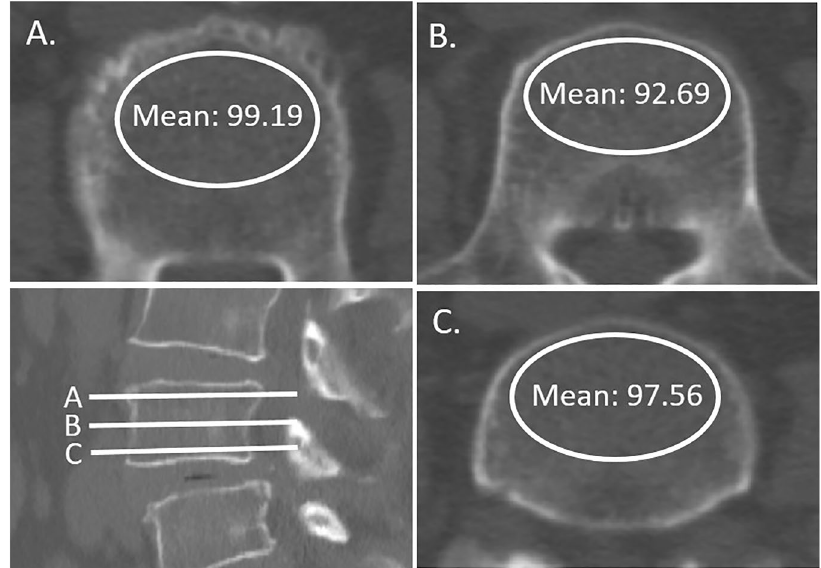
Figure 1. Computed tomography images illustrating the measurement of the HU value in a series of axial views of L1 vertebrae. Regions of interest were measured on the axial images at three separate locations. Slice ( A ) was taken just inferior to the superior end plate, slice ( B ) was chosen at the middle of the body, and slice ( C ) was taken just superior to the inferior end plate. Averaged HU values of the three axial slices were cut-off HU values for L1 vertebrae. HU hounsfield units.